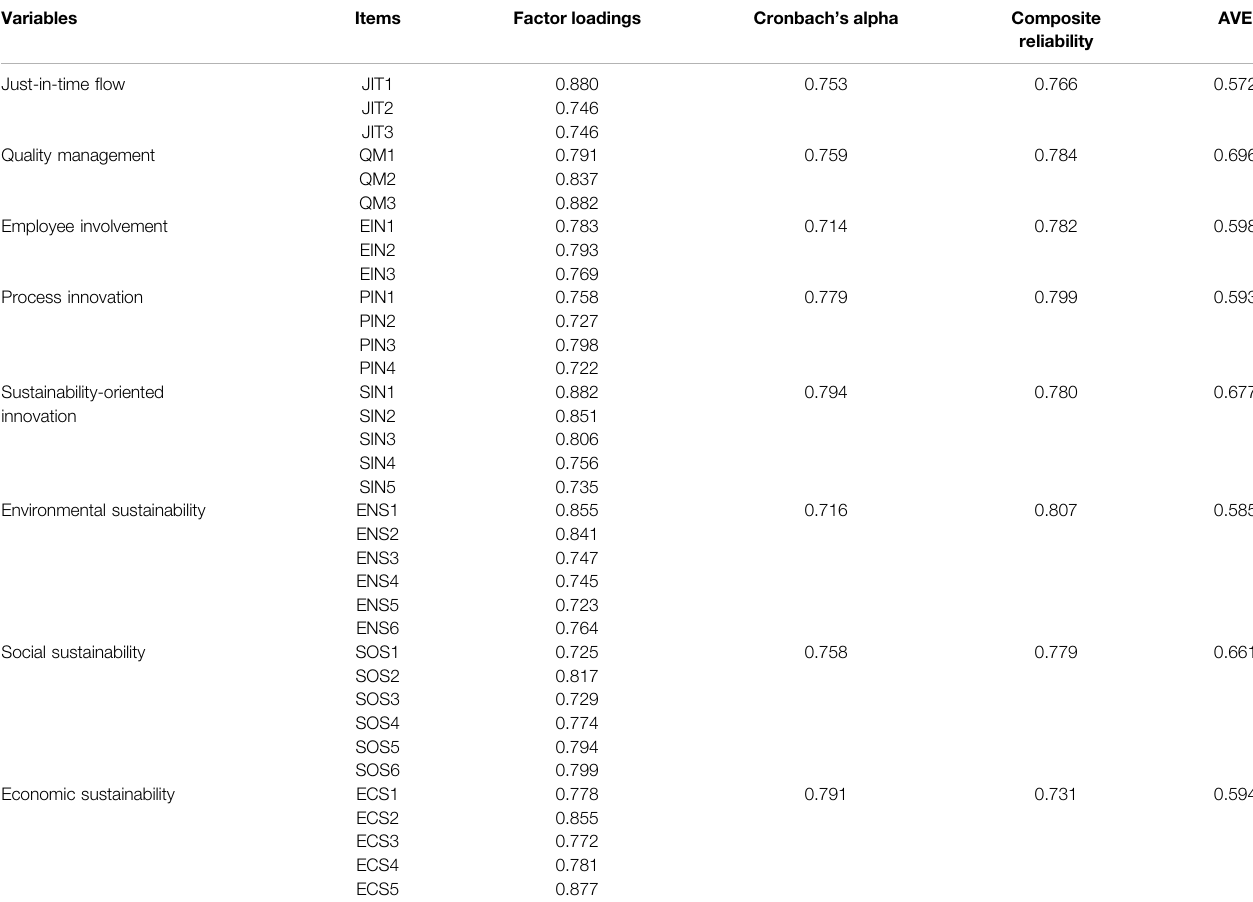
TABLE 3 | Measurement model results ( fi rst order variables). Variables